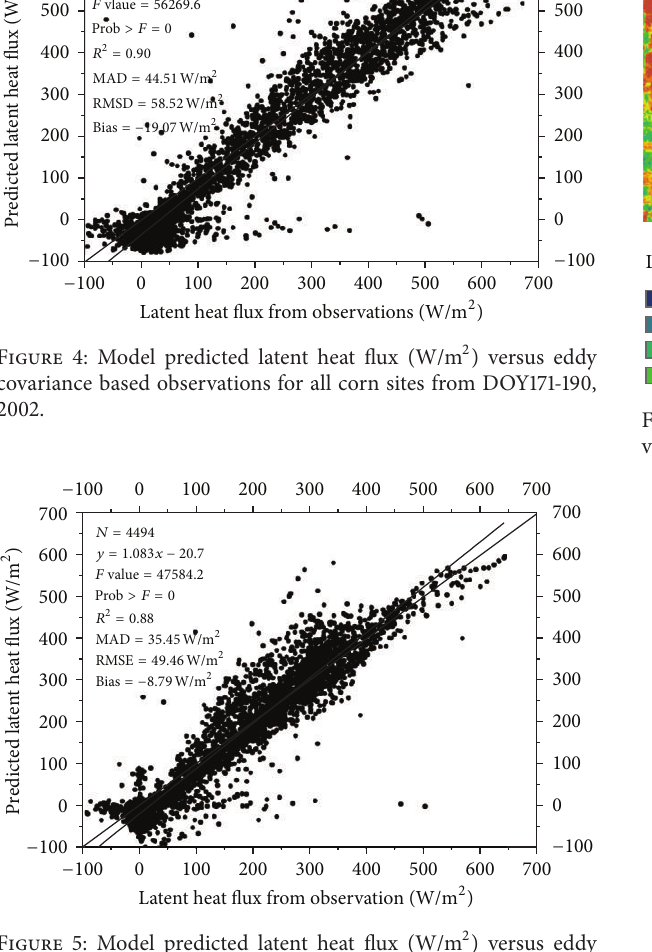
Figure7:Thehistogramofthelatentheatfluxfromdifferentsensors based